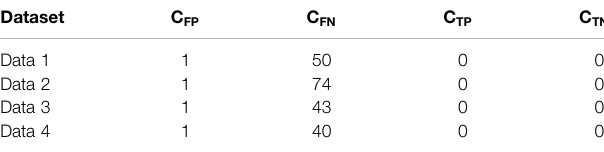
TABLE 5 | Optimization of the cost parameters of CS-ERT for 4